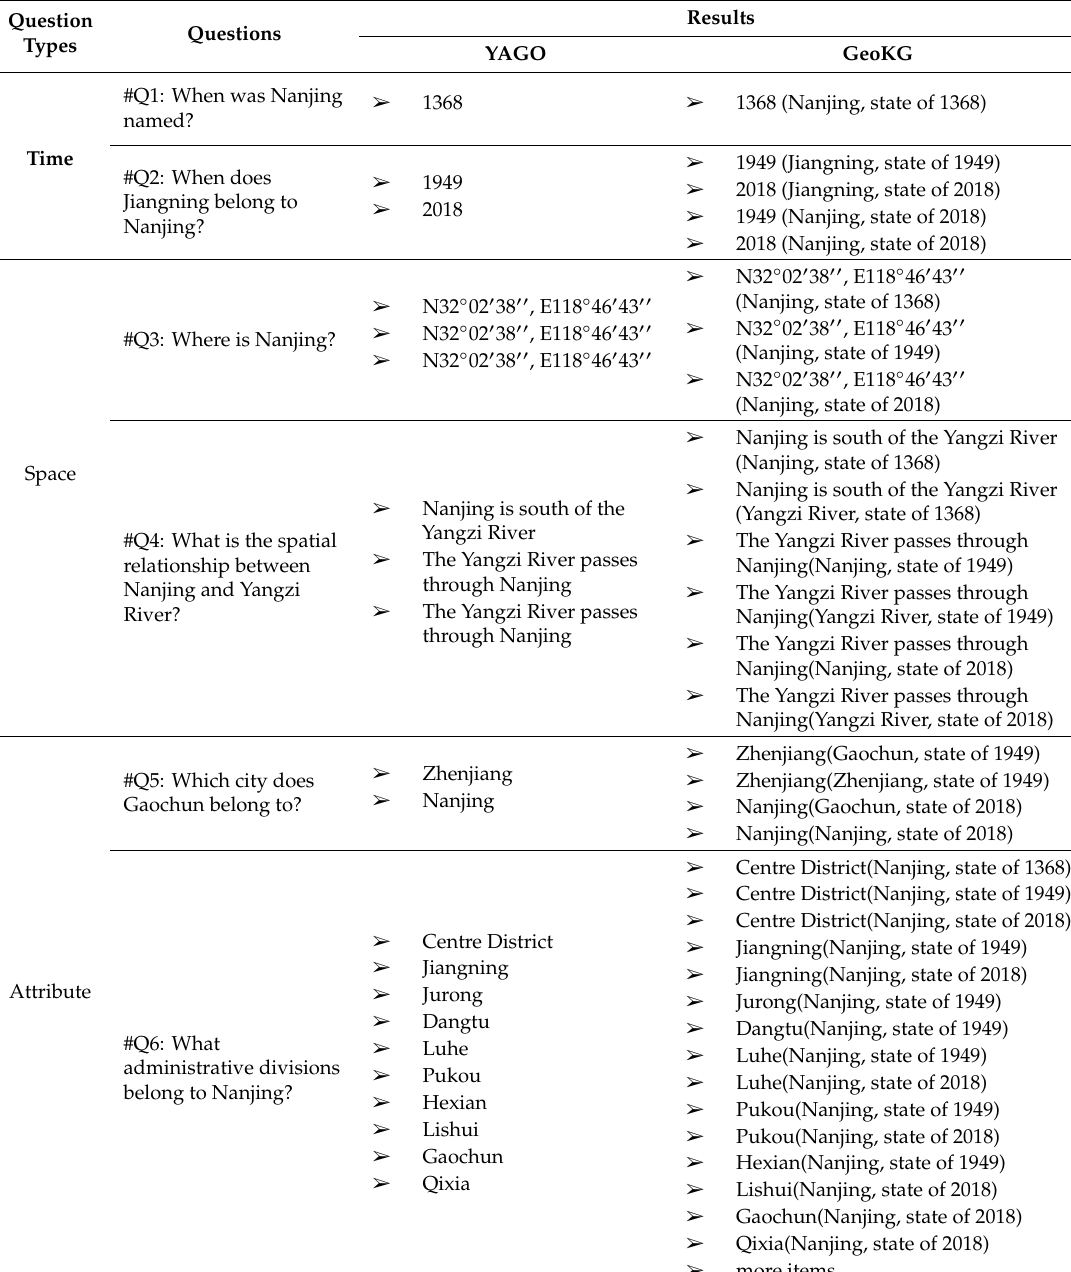
Table 4. The results of YAGO and GeoKG on SPARQL